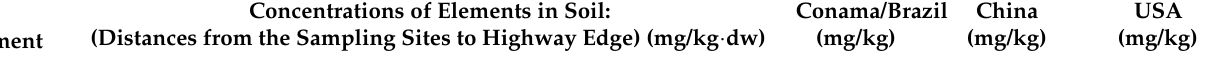
Table 1. Concentrations of elements in soil (median and interquartile deviation) compared to Conama/Brazil [43], soil in China and USA